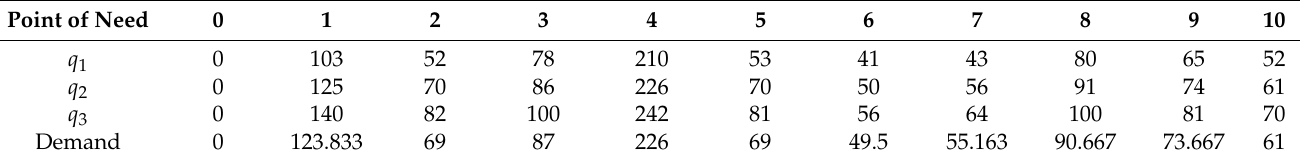
Table 4. Demand parameters.